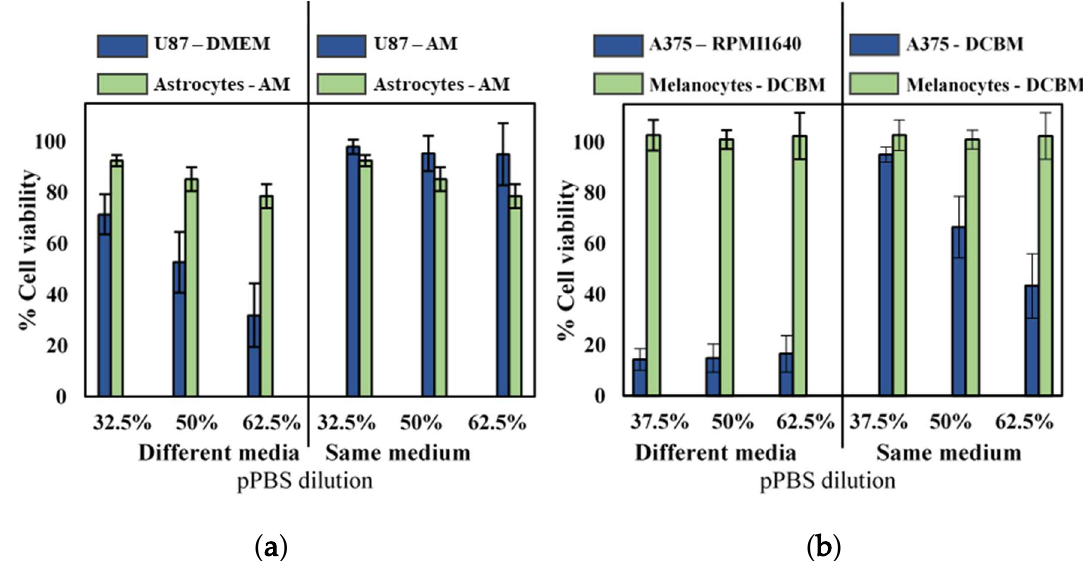
Figure 3. Analysis of the selectivity with the indirect treatment for brain cancer and skin cancer. A 5-min treatment with a gas flow rate of 1 slm and a gap of 6 mm was used to create the pPBS, which we further diluted. Comparison of ( a ) brain and ( b ) skin cancer cells in their common medium (blue solid bars on the left side) with non-cancerous cells in their common medium (green solid bar on the left side) appeared to show selectivity in all cases. However, when compared to the cancer cells in the advanced media (on the right side of the graph), the selectivity was not found. Hence, this clearly shows that the selectivity was affected by the cell culture medium. This is important to realize, to avoid drawing false conclusions. Data are represented as mean ± standard deviation (SD) of three independent experiments with at least two replicates. Statistical significance of all treatment conditions was compared to untreated. * p < 0.05, ** p < 0.01, and *** p < 0.005 (one-way ANOVA).